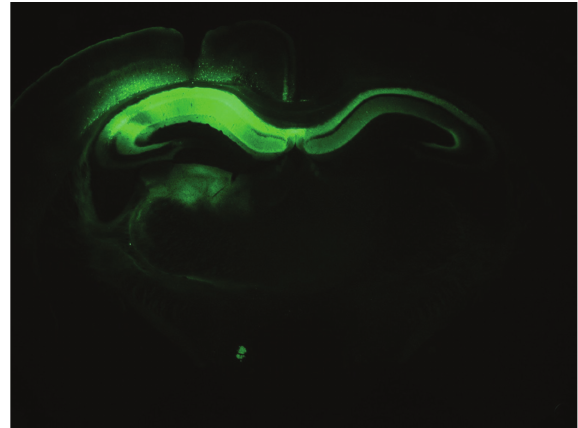
Figure 1: Expression of EGFP following hippocampal injection of AAV1/2.EGFP is long-lasting. Six months following intracerebral injection of the AAV.EGFP vector, the transgene remained expressed in the CA1/2 subfields of the hippocampus and in the deeper layers of the cortex. Expression of EGFP is also evident in and likely propagates along axonal projections of the